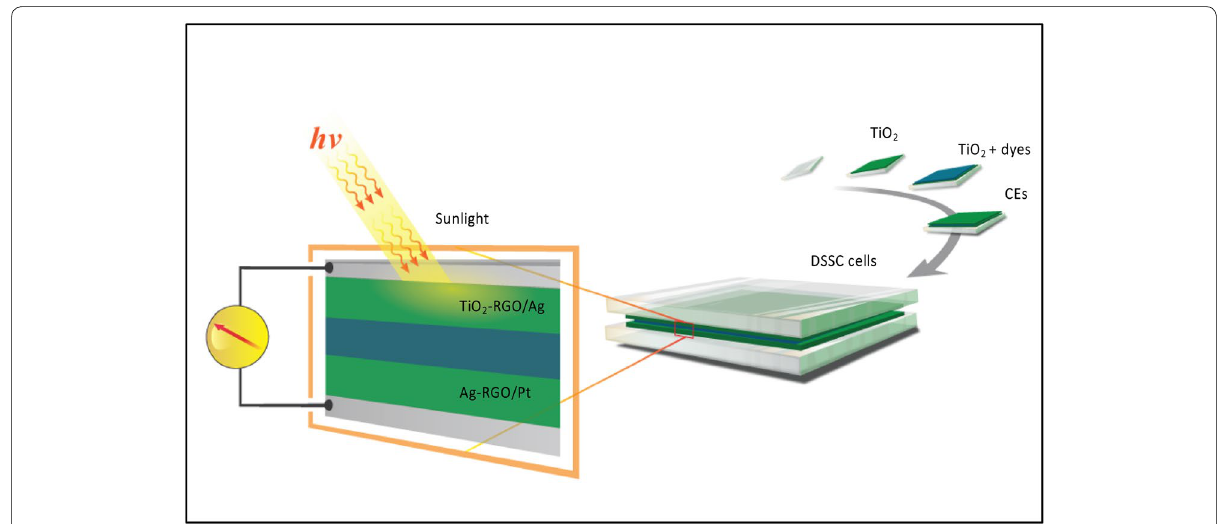
Fig. 1 Schematic diagram for counter electrode